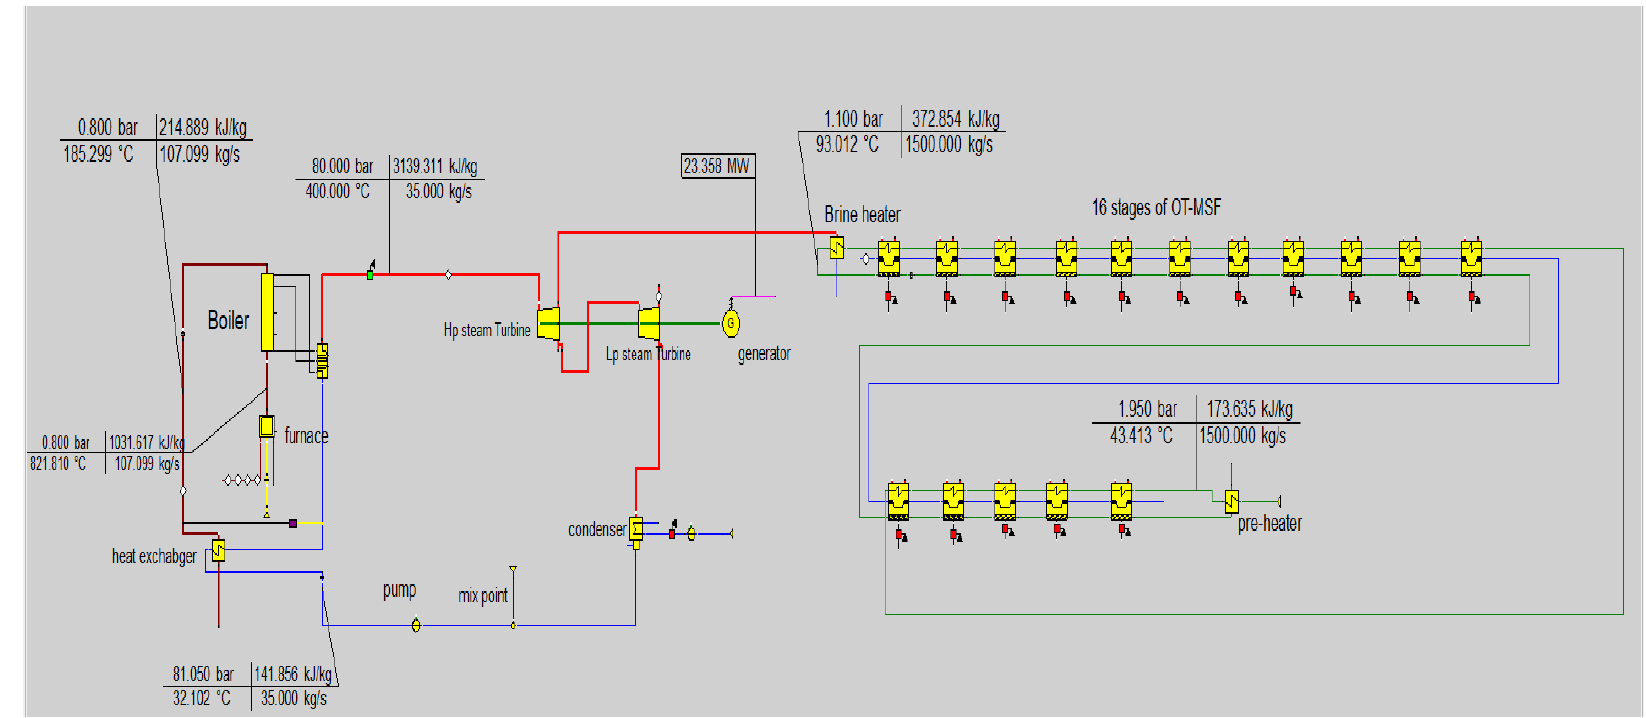
Figure 8. EBSILON model for the WI plant to produce power and potable water. Water, Steam, Heat transfer fluid (Vp-1), Water desalination.